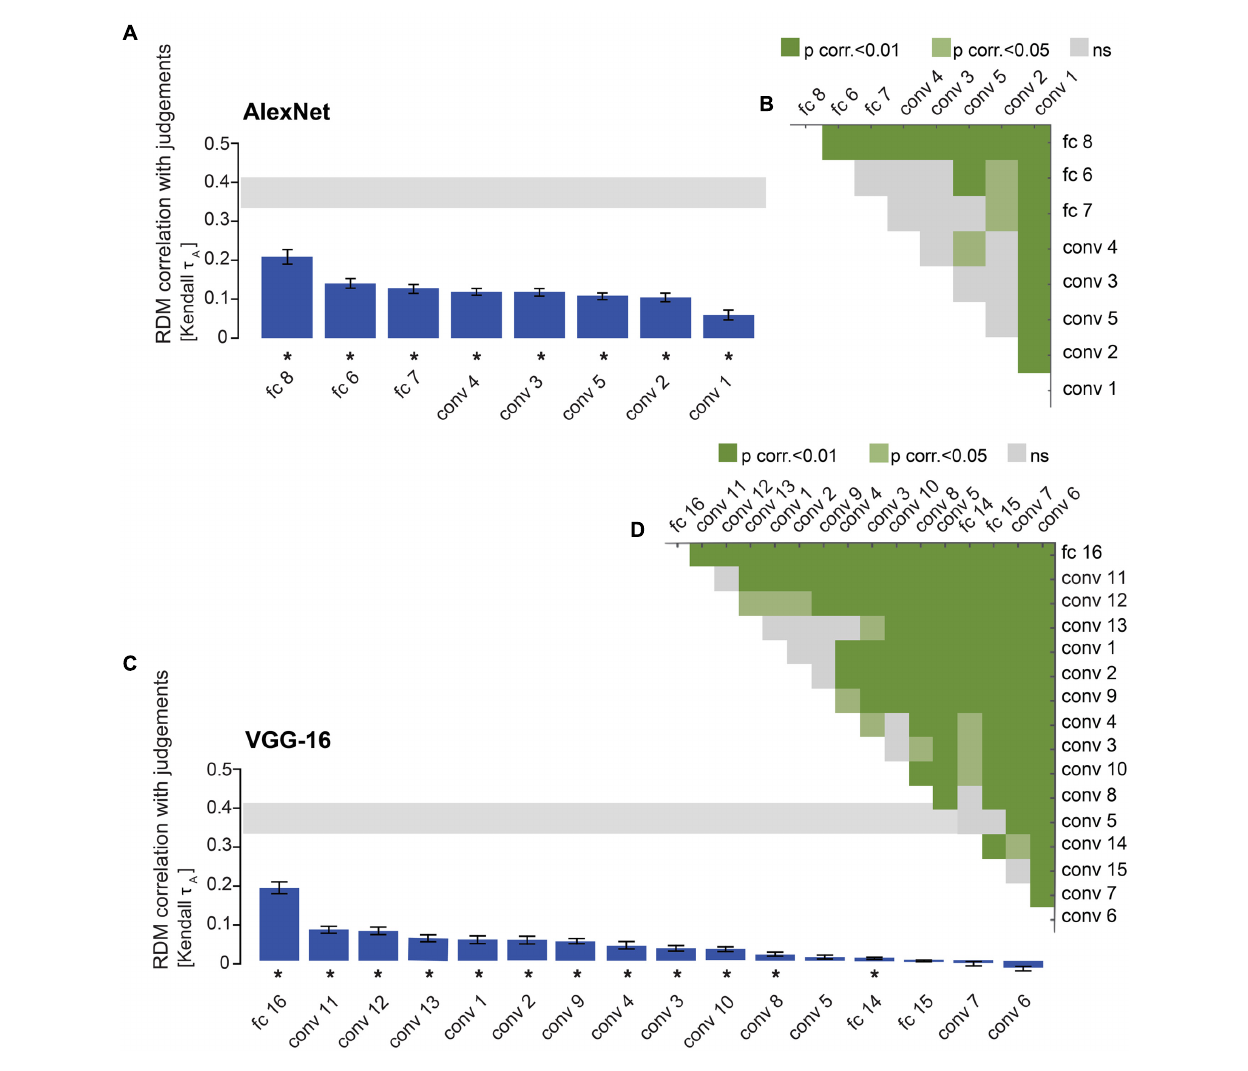
FIGURE 6 | DNN performance at explaining similarity judgments: late layers outperform early layers. (A) Bars show the correlation between the similarity-judgment RDMs and each fitted AlexNet layer RDM. Noise ceiling and significant correlations are indicated using the same conventions as in Figure 4 . (B) Pairwise differences between model performance of fitted AlexNet layer RDMs, using the same conventions as in Figure 4 . (C) Bars show the correlation between the similarity-judgment RDMs and each fitted VGG-16 layer RDM. (D) Pairwise differences between model performance of fitted VGG-16 layer